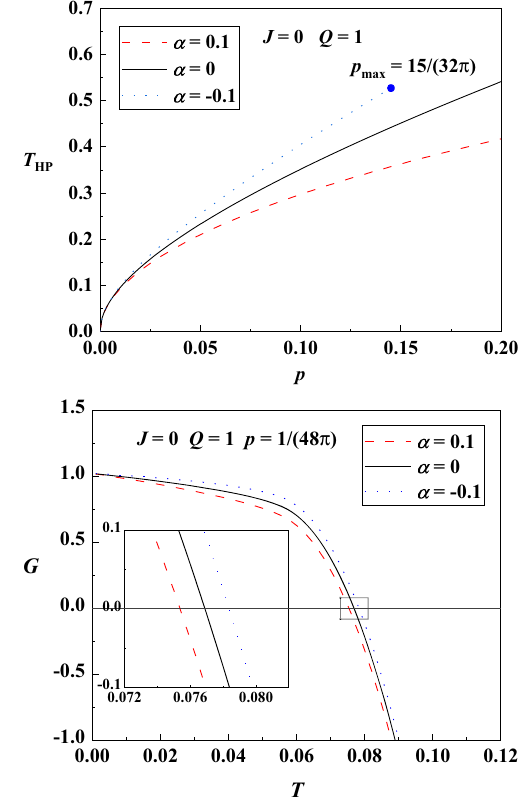
13, with different values of Q . We observe that, (1) there is no bound of p , and the HP phase transitions can happen at all pressures; (2) at a given pressure, T HP increases with Q ; (3) the black hole temperature T can reach zero, without lower bound (for the Schwarzschild–AdS black hole, there is a minimal black hole temperature T 0